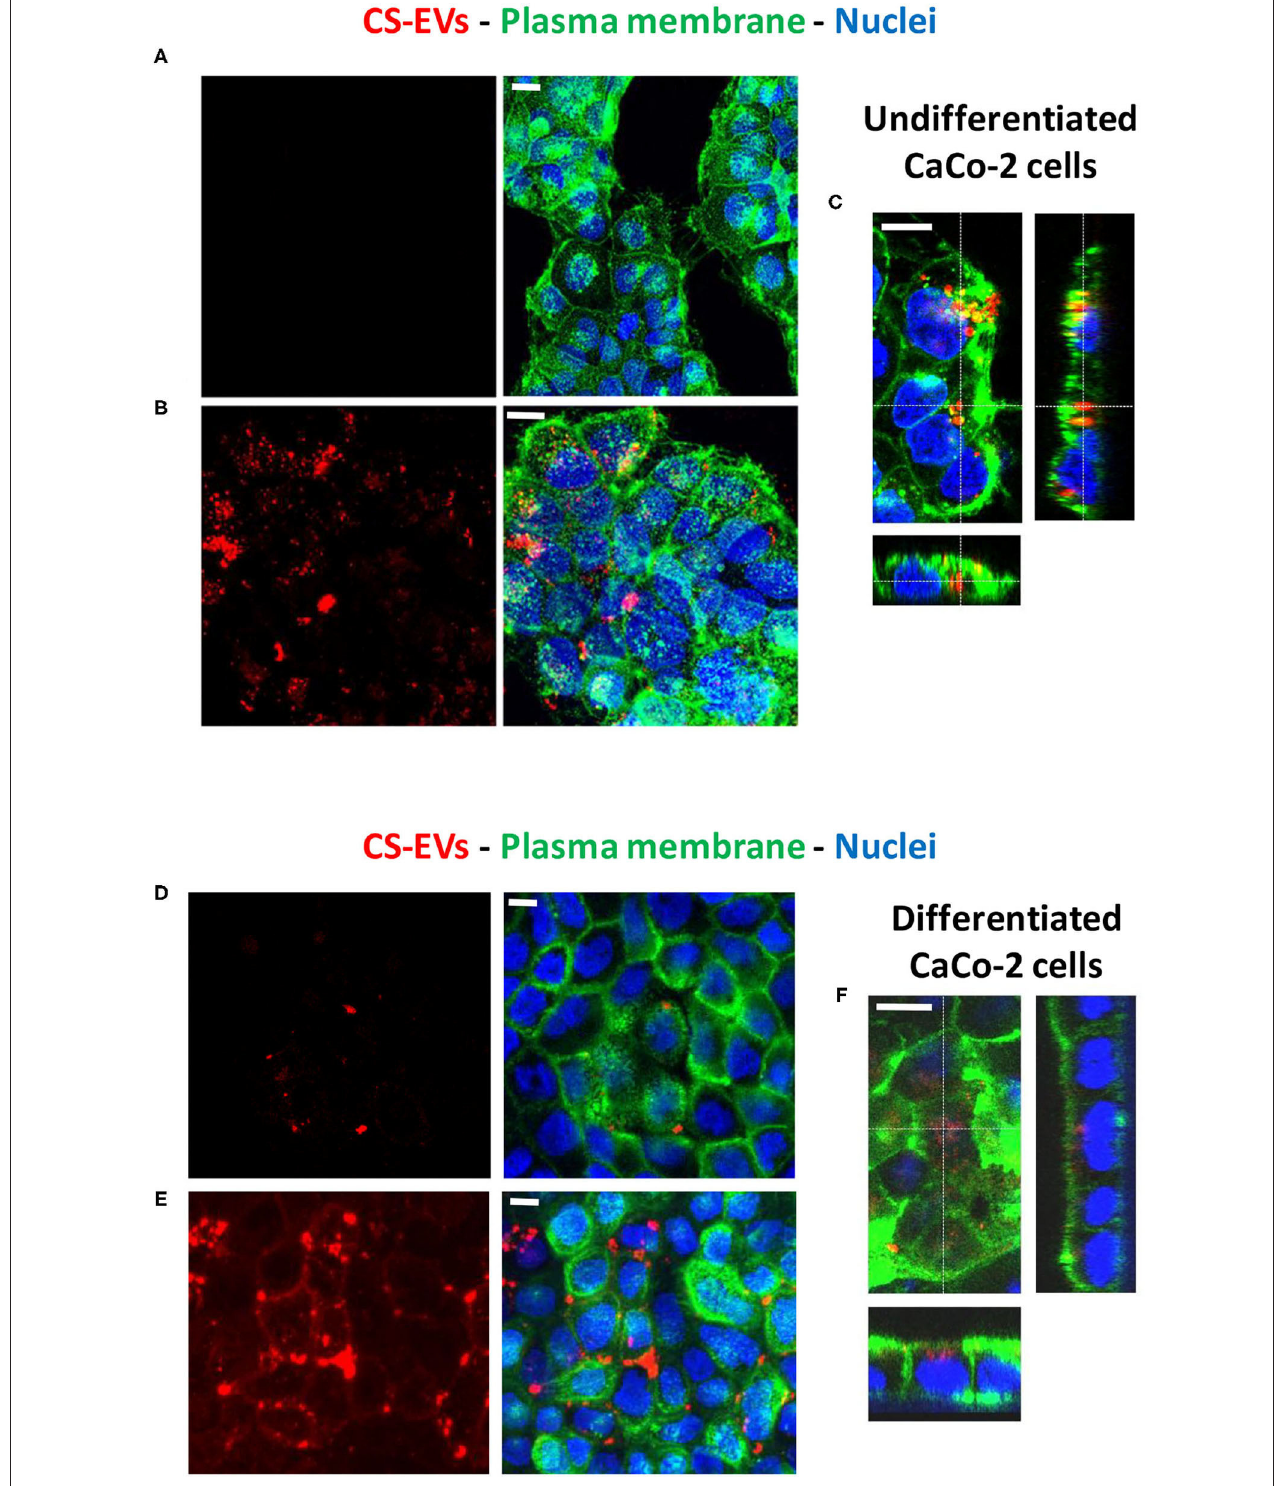
FIGURE 4 | Uptake of CS-EVs by intestinal epithelial cells. (A) Undifferentiated CaCo-2 cells. (B) Undifferentiated CaCo-2 cells treated with 5 µ g/ml of Alexa-labeled CS-EVs for 6h. (C) Representative Z series confocal microscopy images of undifferentiated CaCo-2 cells showing the internalization of CS-EVs. (D) Differentiated CaCo-2 cells treated with 5 µ g/ml of Alexa-labeled CS-EVs for 6h (E) and 24h. (F) Representative Z series confocal microscopy images of epithelial CaCo-2 cells, showing the internalization of CS-EVs. White scale bars represent 5 µ m.